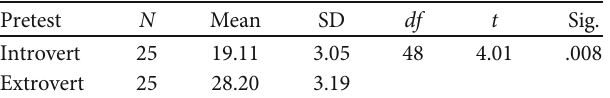
T ABLE 5: Independent sample t -test between posttests of introvert and extrovert